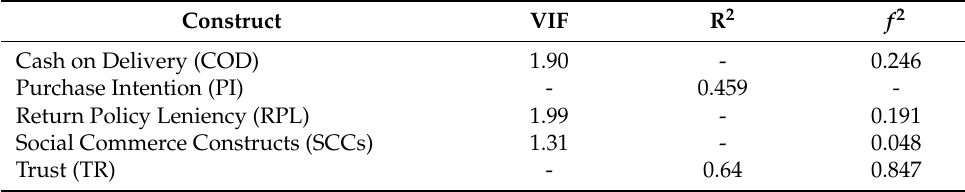
Table 7. Explanatory power and effect